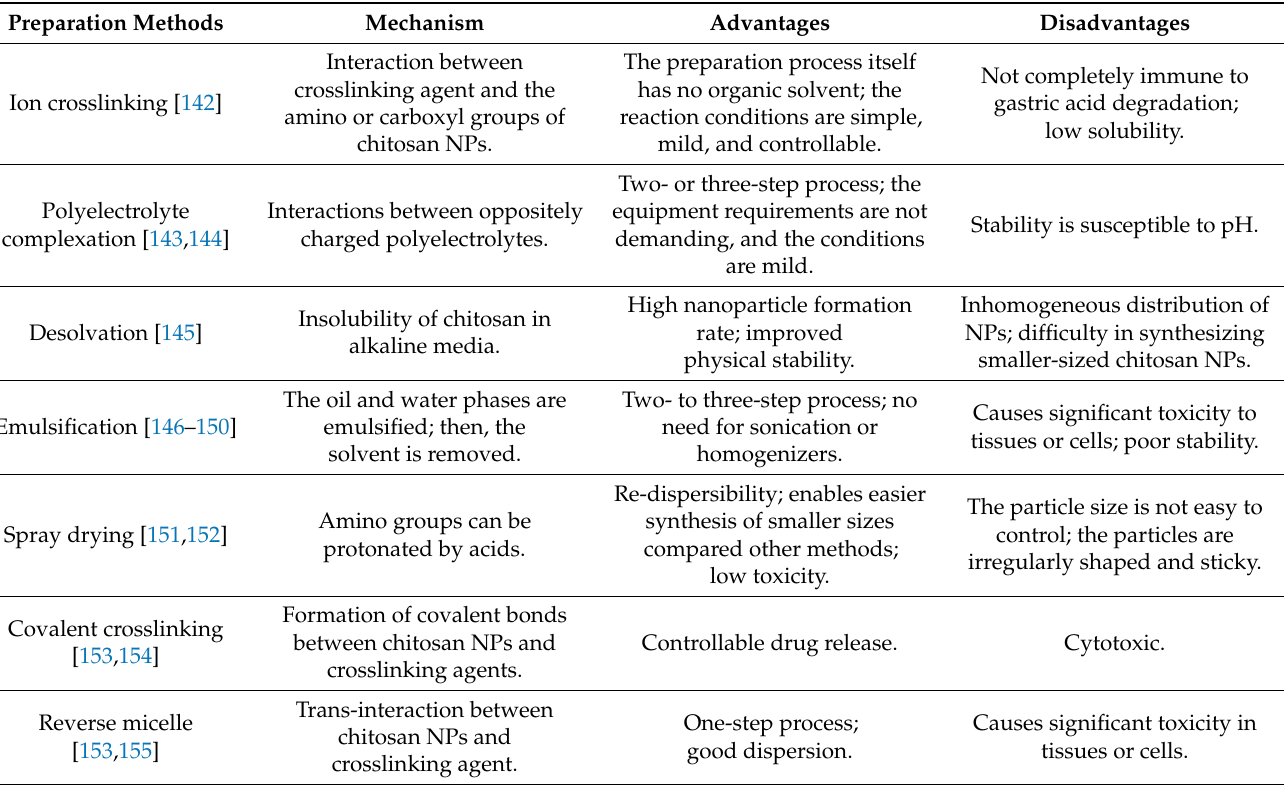
Table 5. Preparation methods of chitosan